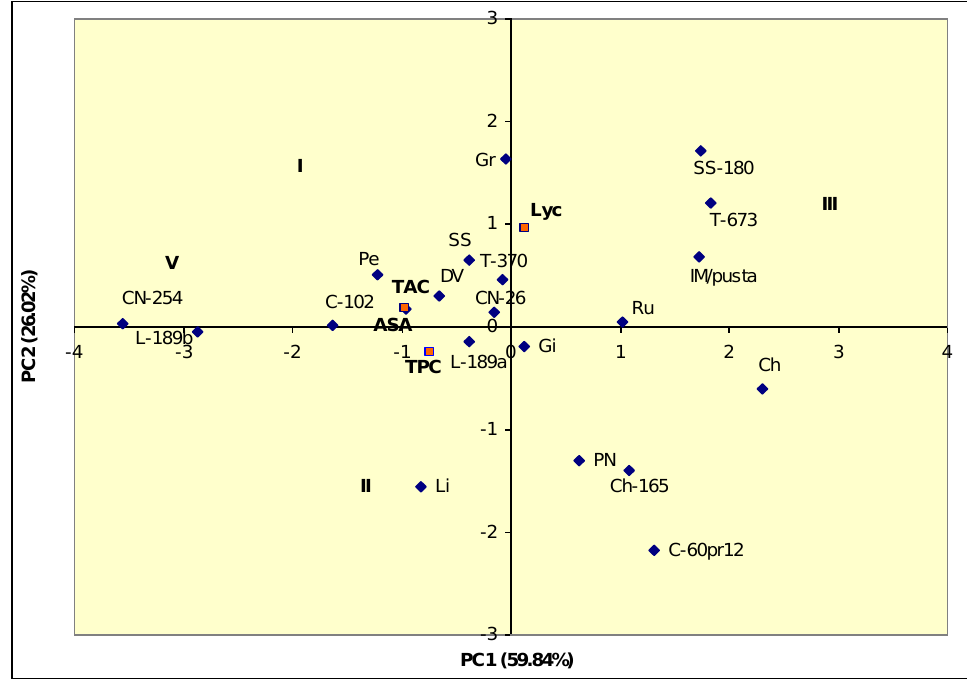
Figure 2. Biplot of the first two principal components for 20 tomato landraces and four quality traits.